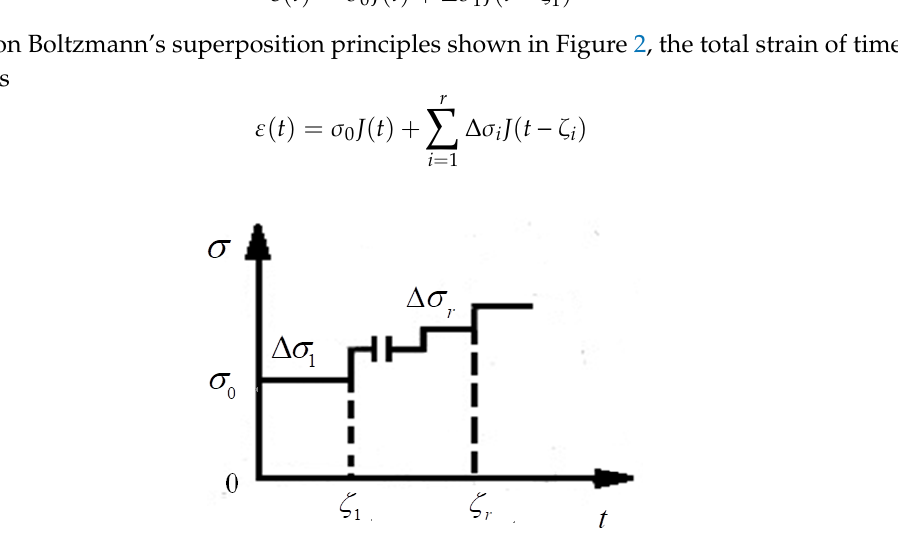
Figure 2. Boltzmann's superposition principles. Figure 2. Boltzmann’s superposition